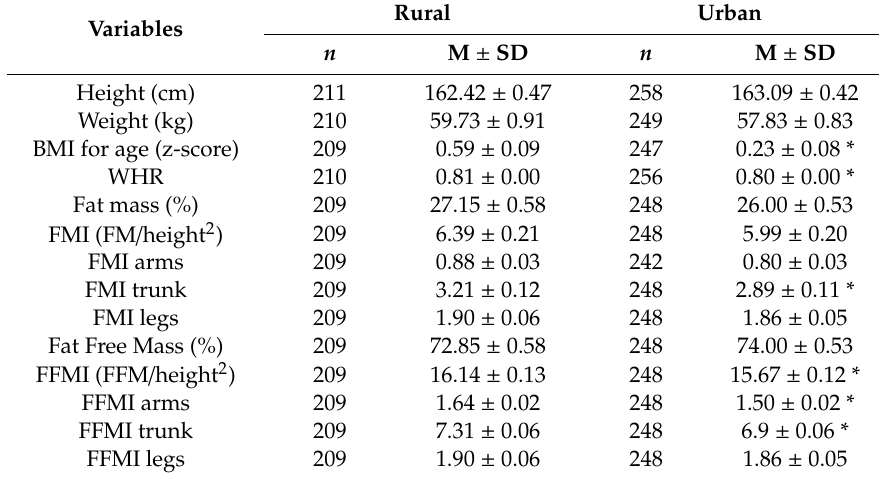
Table 1. Descriptive statistics and comparisons of anthropometry and body composition in rural and urban adolescents.